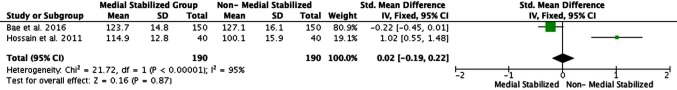
 Forest plot of Knee ROM at final follow-up of medial stabilized group and non-medial stabilized group (SD: Standard Deviation; CI: Confidence Interval).